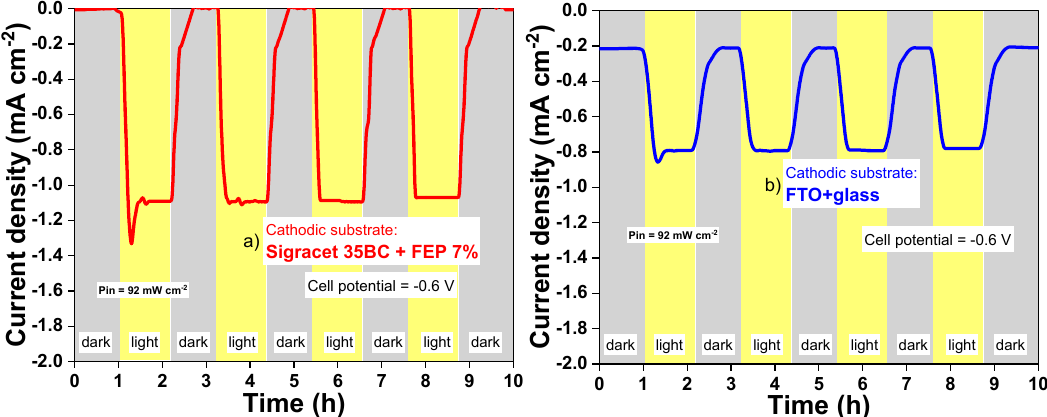
Figure 9. Potentiostatic durability test (applied cell bias of − 0.6 V) of the PEC cells based on the hydrophobic backing layer ( a ) and FTO ( b ) cathode substrates contained into a quartz holder filled with water for cell hydration.